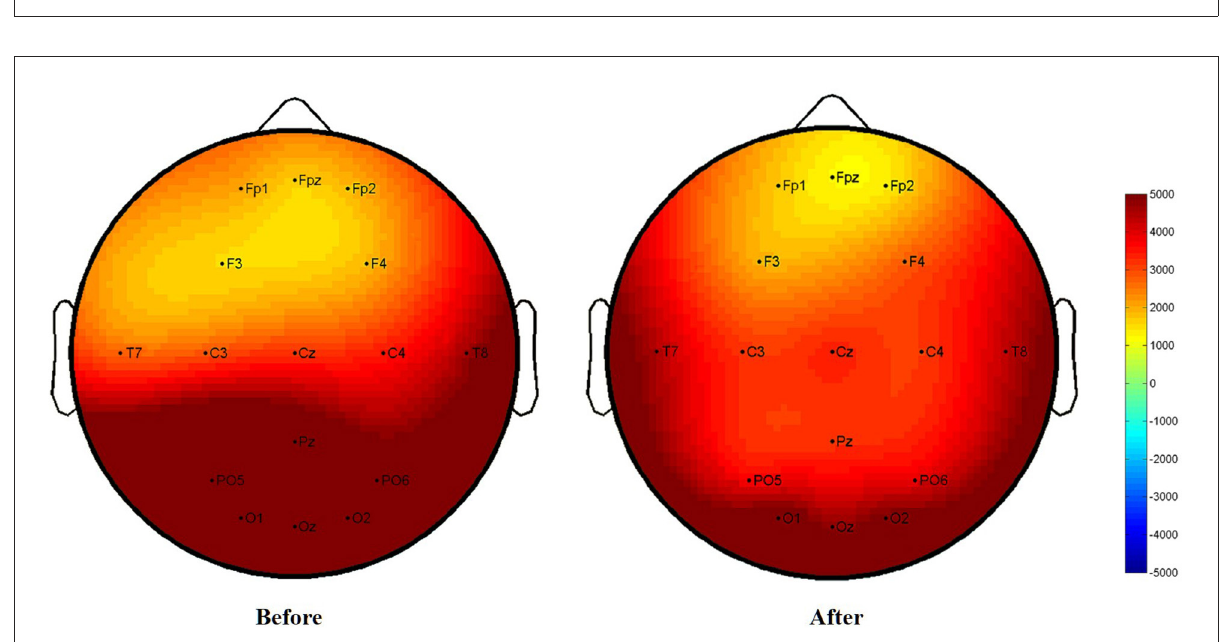
FIGURE9 Before and after treatment of the sham acupuncture group